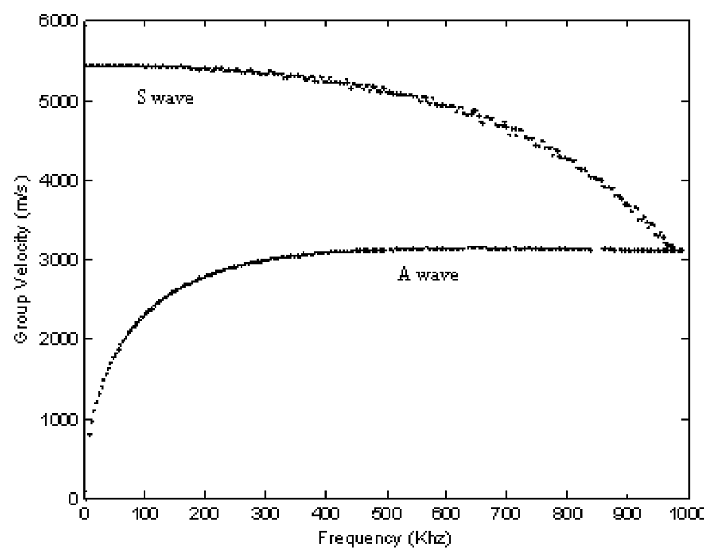
Fig. 4. Group velocities for a 2 mm thick aluminum